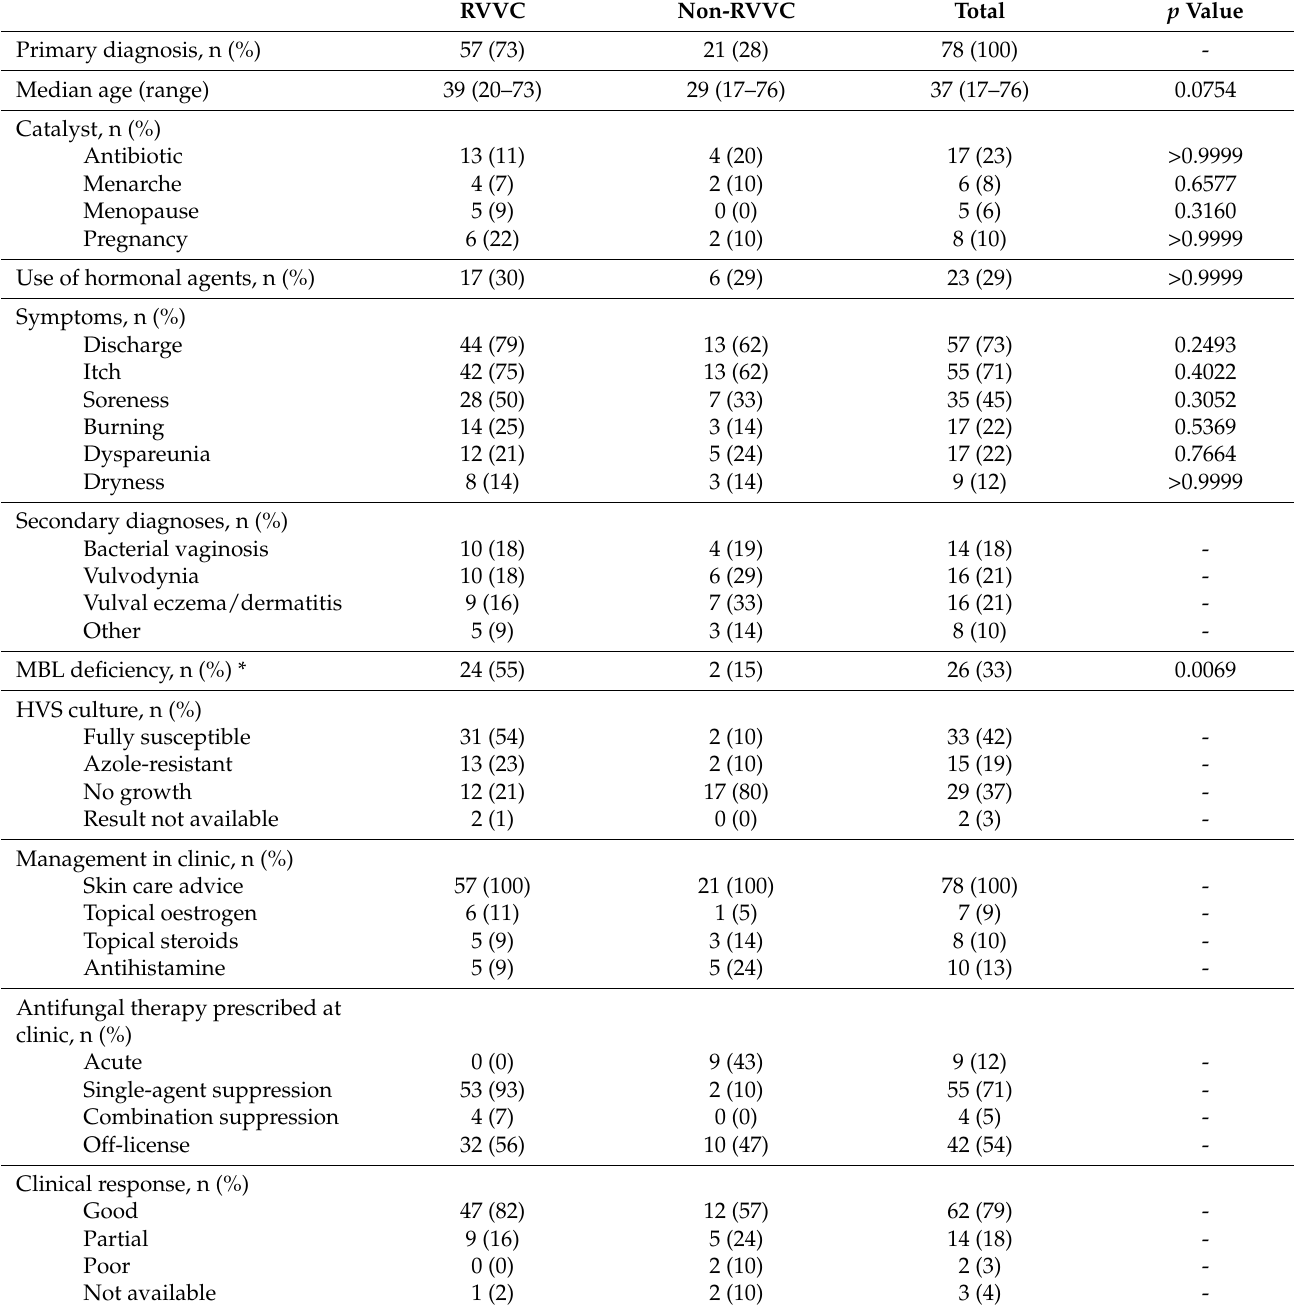
Table 3. Patient characteristics, diagnoses and